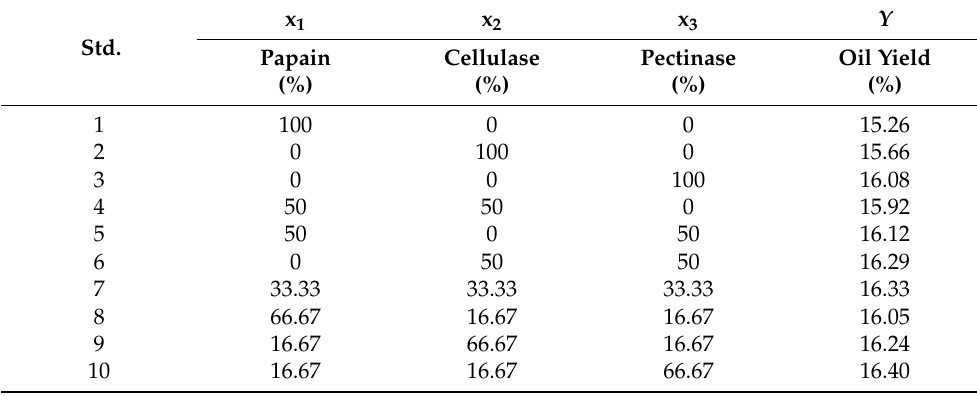
Figure 2. Simplex design plot in amounts. Table 2. Mixtures of three enzymes used for aqueous enzymatic extraction with their corresponding oil yields.